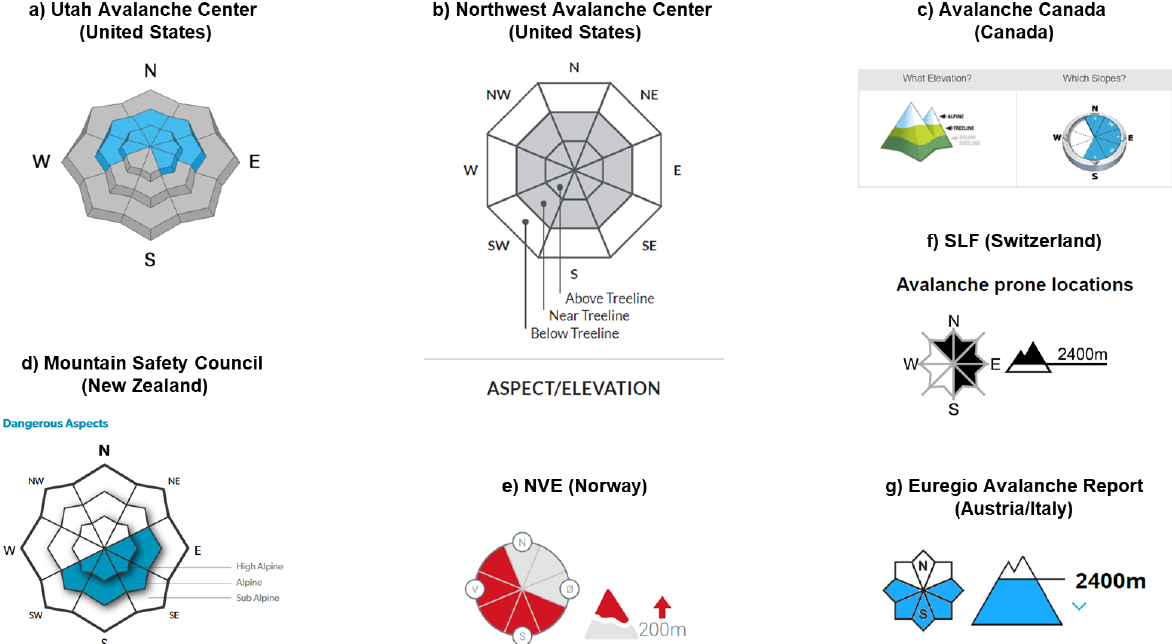
Figure 1. Screenshots of examples of aspect and elevation representation of avalanche problems in public avalanche bulletins. (a) Utah Avalanche Center (USA; https://utahavalanchecenter.org, last access: 1 April 2021). (b) Northwest Avalanche Center (USA; https://nwac.us, last access: 1 April 2021). (c) Avalanche Canada (Canada; https://avalanche.ca, last access: 1 April 2021). (d) New Zealand Mountain Safety Council (New Zealand; https://www.avalanche.net.nz, last access: 1 April 2021). (e) Norwegian Avalanche Warning Service (Norway; https: //www.varsom.no/en/avalanche-bulletins/, last access: 1 April 2021). (f) Swiss Avalanche Warning Service (Switzerland; https://www.slf.ch/ en/avalanche-bulletin-and-snow-situation.html, last access: 1 April 2021). (g) Euregio Avalanche Report (Austria/Italy; https://avalanche. report/bulletin/latest, last access: 1 April